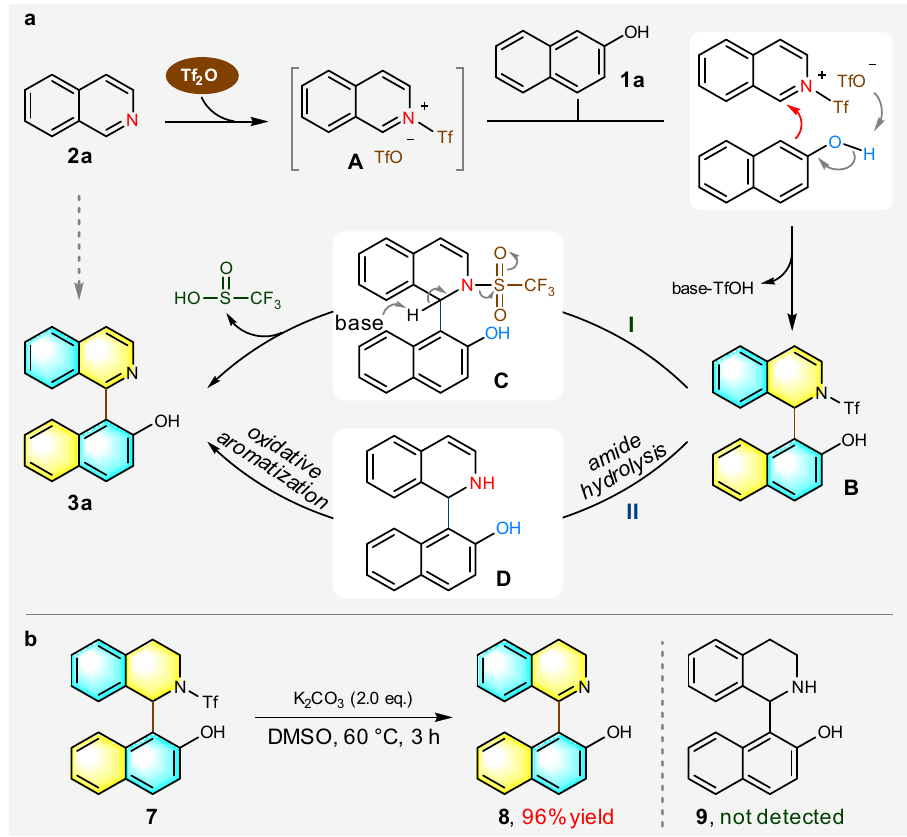
Fig. 7 Proposed reaction mechanism and control experiment. a Proposed reaction pathway. b Control